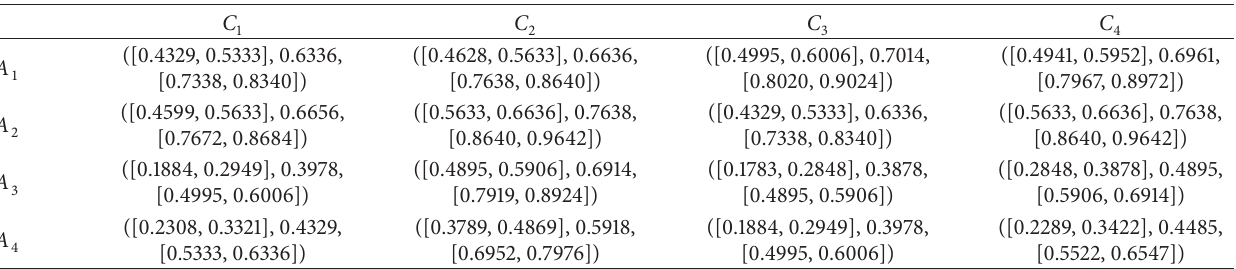
Table 5: Triangular interval type-2 fuzzy decision matrix